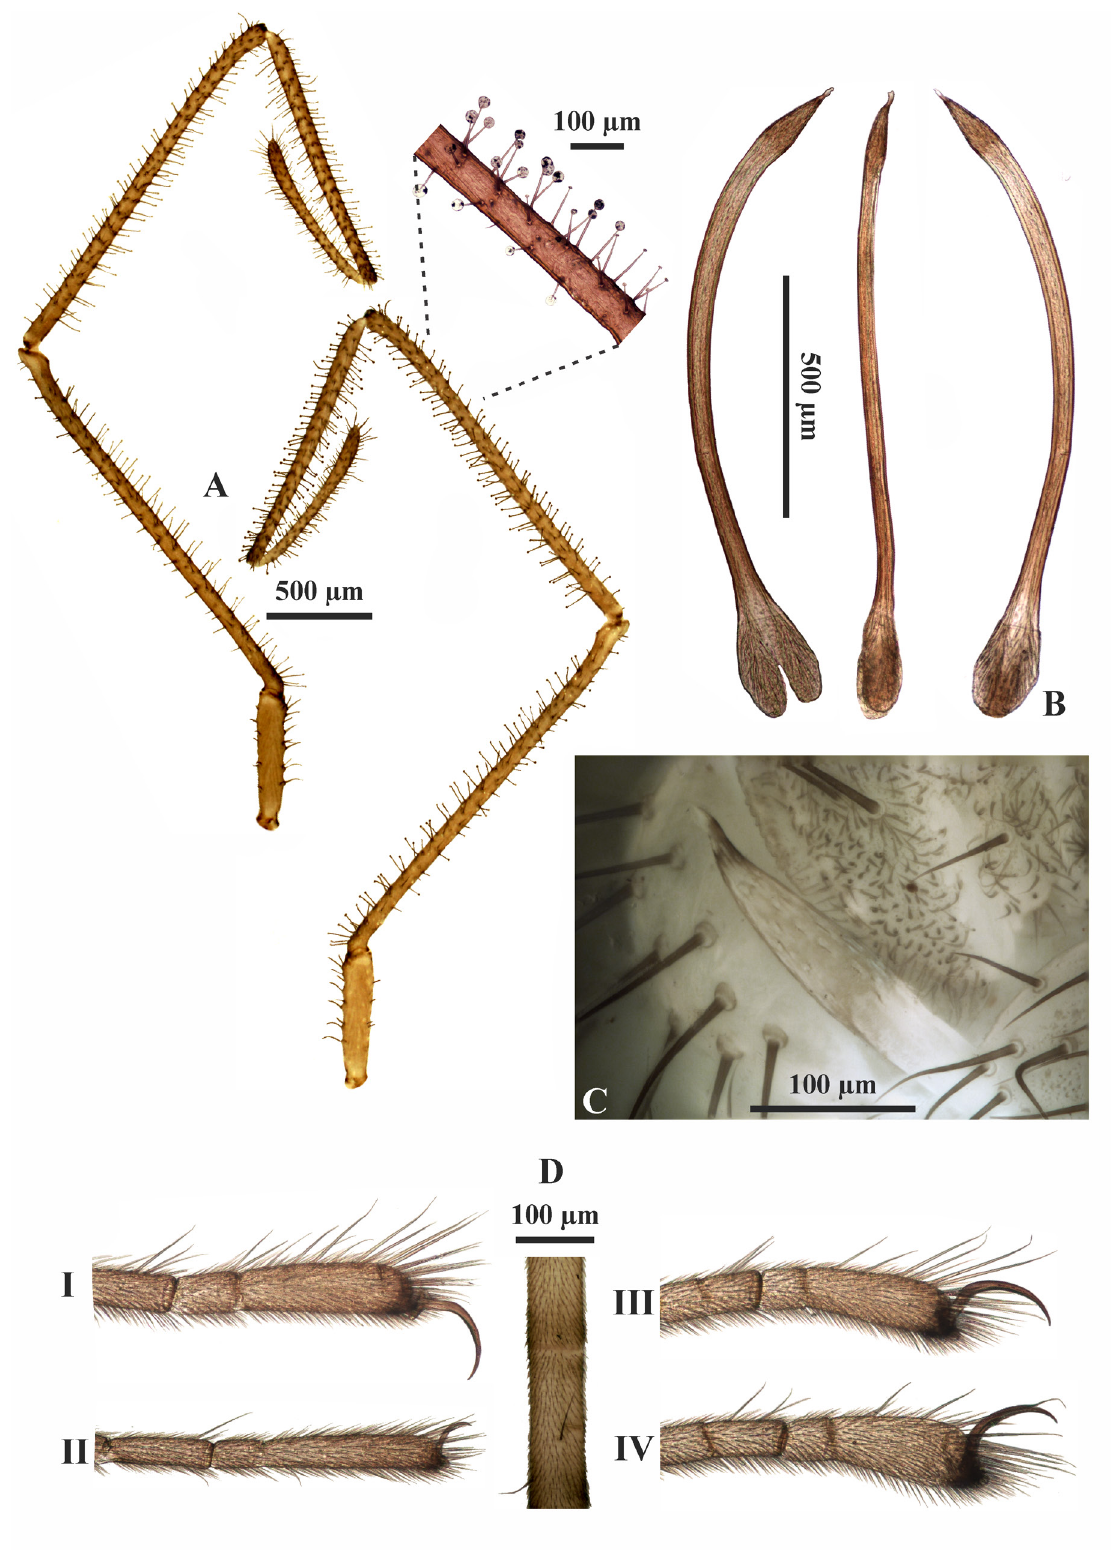
Fig. 3. Nemaspela borkoae sp. nov., ♂ holotype (PMSL-Opiliones-PK&TN 4/2019). A . Right pedipalp, lateral (left) and medial (right) views. B . Penis, ventral, lateral and dorsal view. C . Penis protruding through genital opening. D . Pseudoarticles in femur II, and distal tarsomerae I−IV with claws, lateral